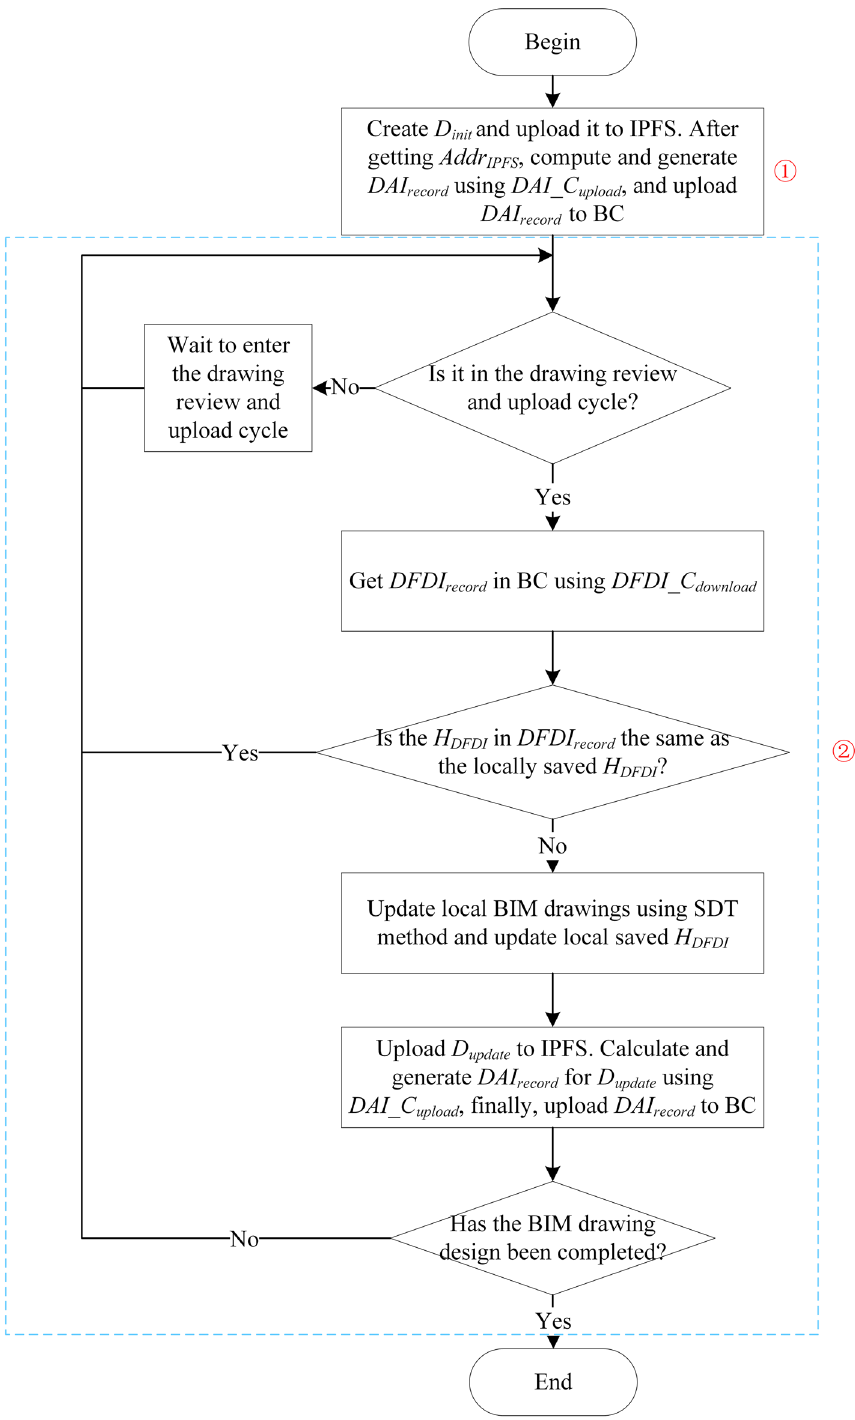
Figure 7. Operation process of BIM drawing